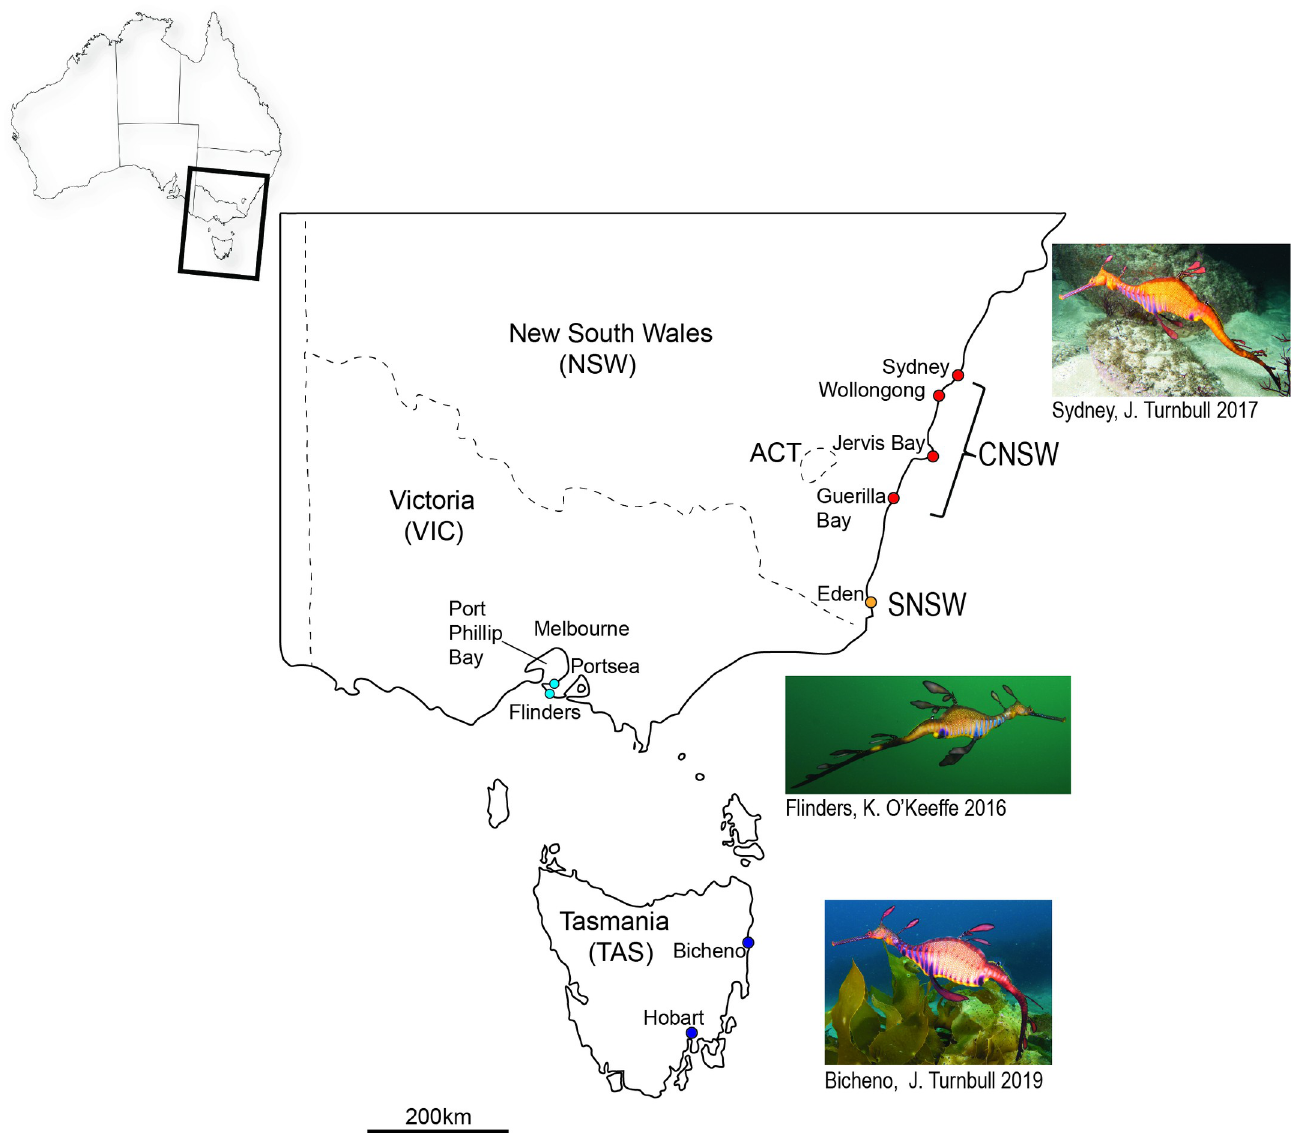
Fig 1. Map of sample sites. CNSW (Central New South Wales, red dots) with Sydney N = 13 and Botany Bay N = 19, Wollongong N = 1, Jervis Bay N = 4, Guerilla Bay N = 3; SNSW (Southern New South Wales, yellow dot) with Eden N = 8; VIC (Victoria, Mornington Peninsula, light blue dots) with Flinders Pier N = 10, Portsea N = 5; and TAS (Tasmania, dark blue dots) with Bicheno N = 7 and Hobart N = 2. Photos are of adult specimens of the weedy seadragon, Phyllopteryx taeniolatus from three of the sample sites (with photo credit